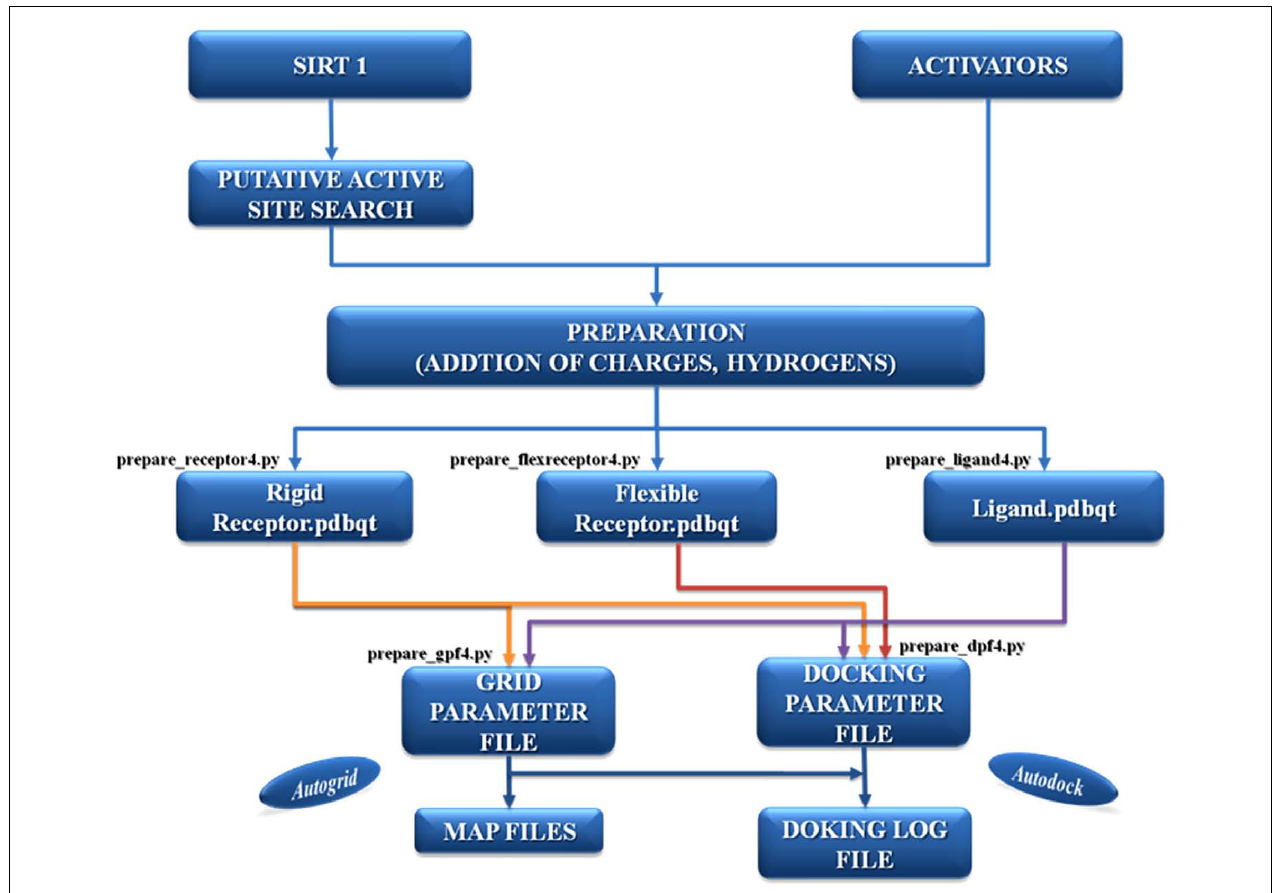
FIGURE 1 |The description of theAutoDock protocol used to simulate the complexes between Sirt-1 and its four activators.